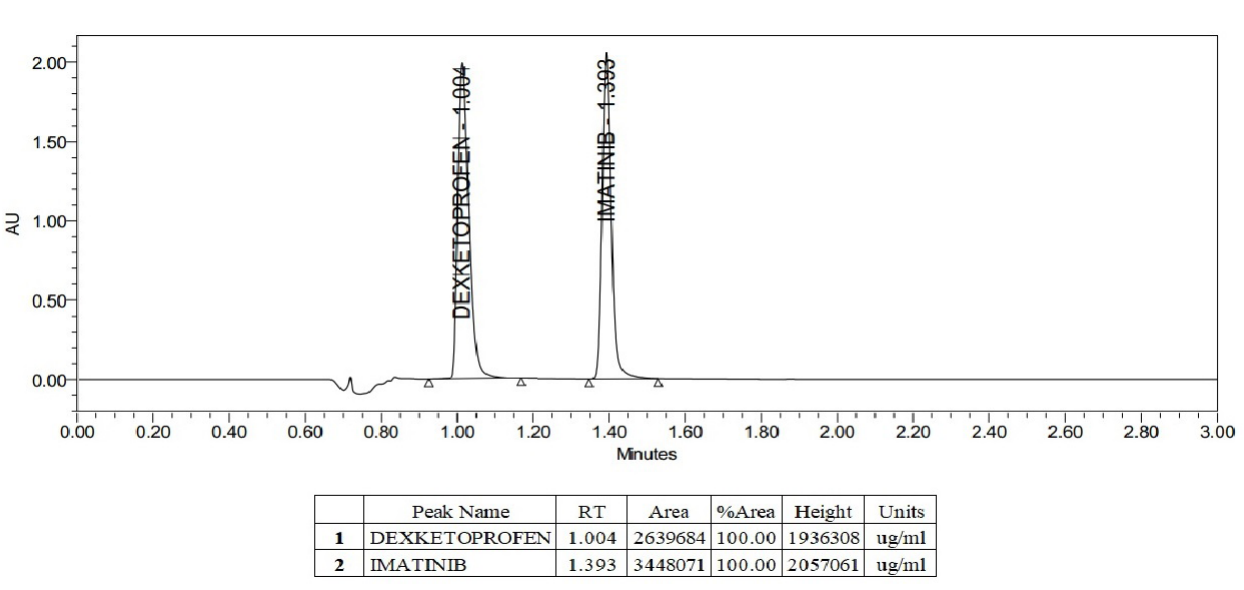
FIGURE 7 - UPLC chromatogram of dexketoprofen trometamol and imatinib mesylate in phosphate buffer.